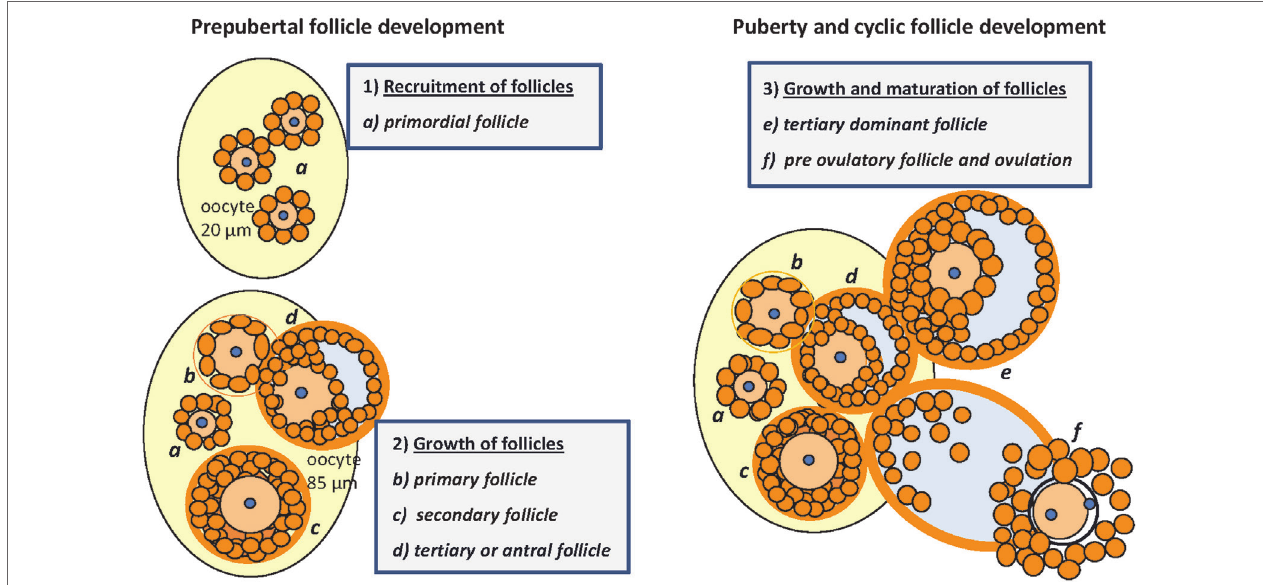
FiGURe 1 | Folliculogenesis in mice: prepubertal follicular development (1) and (2): (a) pool of primordial follicles within the stroma of the neonatal ovary, the oocyte is surrounded by one layer of GC, no TC; nucleus arrested in GV I of meiosis; (b) primary follicle with one layer of cuboidal granulosa cells, signaling the recruitment of TC from the stroma; (c) secondary or preantral follicle with more than one layer of GC, recruitment of TC, and differentiation with low production of androgens; (d) tertiary follicle with formation of the antrum, proliferation of GC, maturation of TC that become steroidogenic under control of LH, increasing androgen production and E2 synthesis in GC under the control of FSH, growing to become the dominant follicle. Puberty and cyclic follicle development (3): (e) tertiary dominant follicle growth with increasing antral volume, mitosis of GC and E2 synthesis → puberty; (f) preovulatory follicle, oocyte with one layer of expanded GC and resumption of meiosis after the LH surge, increasing progesterone production → ovulation [E2, 17beta-estradiol; GC, granulosa cells; TC, thecal cells; GV, germinal vesicle; LH, luteinizing hormone; FSH, follicle-stimulating hormone; follicle classification according to (1, 4, 10,